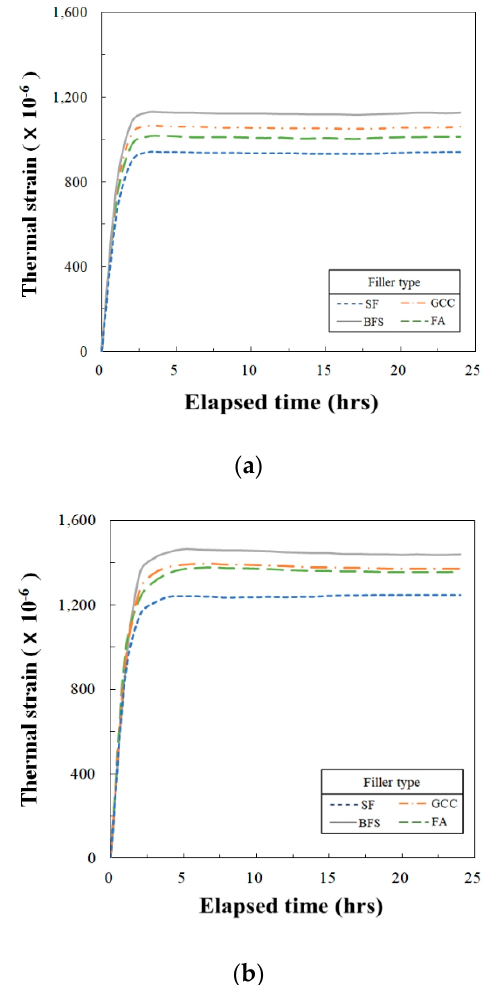
Figure 10. Variations in thermal strain by hardener and filler type: ( a ) AAMT hardener and ( b ) CAMT hardener.